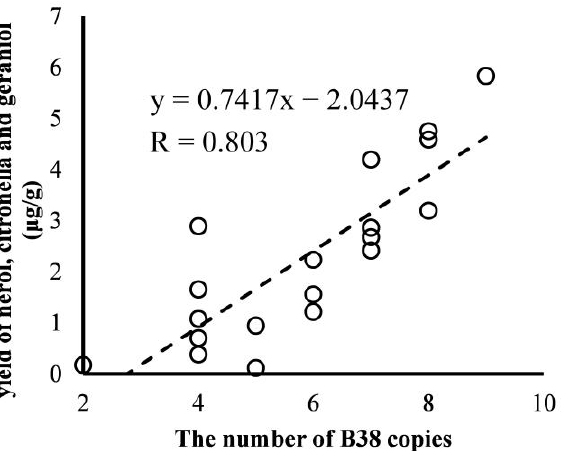
Figure 3. Correlation between the total yield of nerol, citronellol and geraniol and the repeat number of B38.